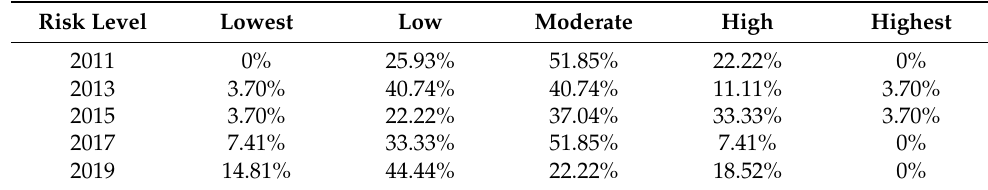
Table 2. Each risk level percentage during 2011, 2013, 2015, 2017, and 2019. Risk